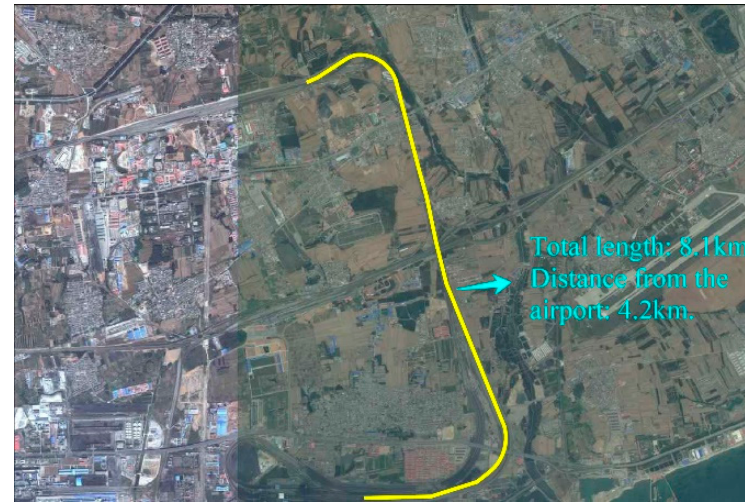
Figure 3. Satellite map of the experiment area.